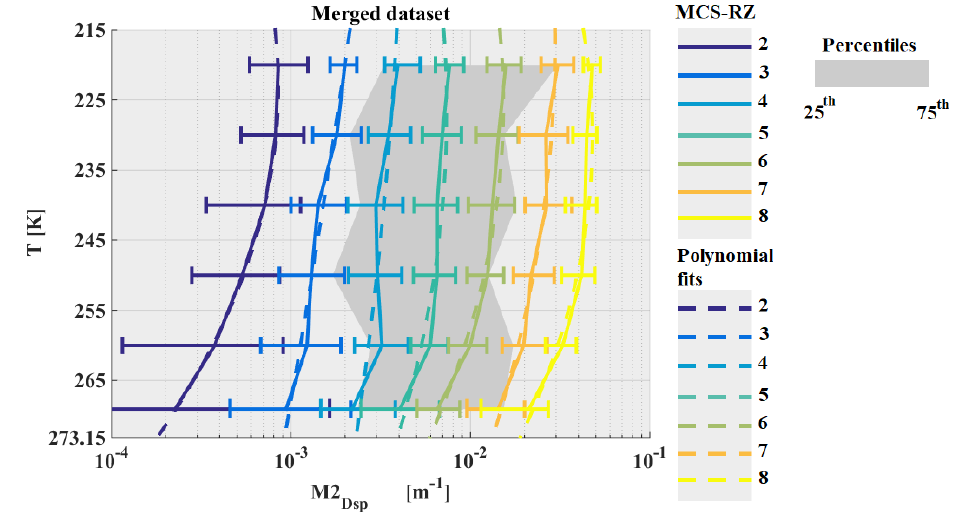
Figure E1. The same as Fig. 5 but for M 2 , Dsp m − 1 , where PSD is used as a function of equivalent spherical diameter.